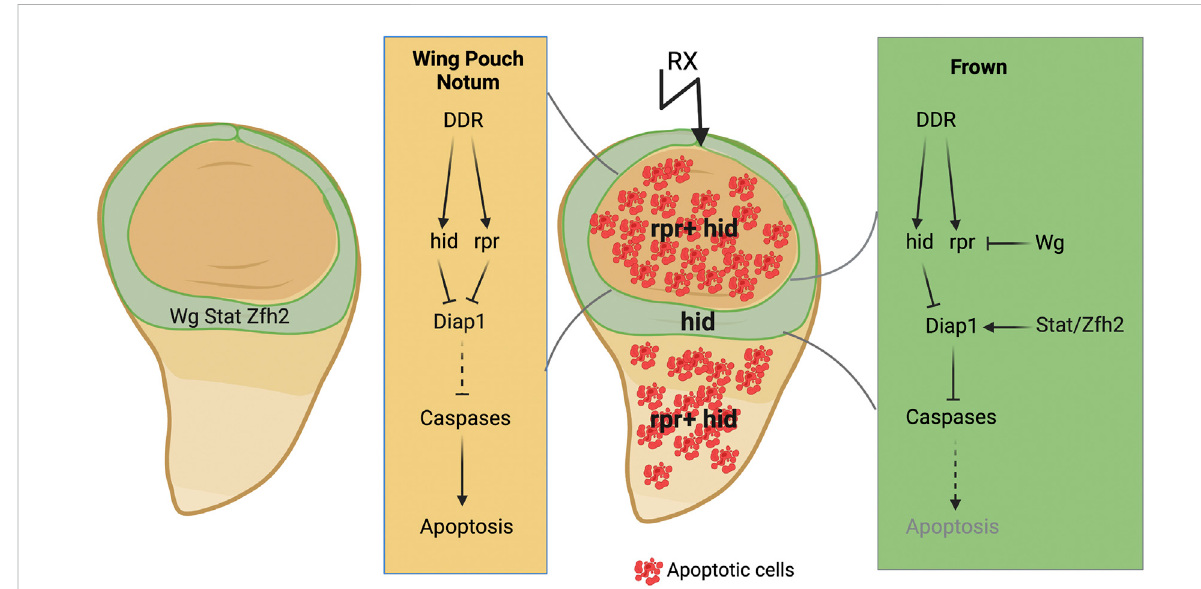
FIGURE 4 A schematic diagram showing the different responses after IR in the three main parts of the wing disc. In greenis indicated the frown(hinge). In this region Wg and Stat signalling are strongly activated. The function of these signalling pathways in this domain prevents the induction of rpr in response to IR, and therefore apoptosis. Created with